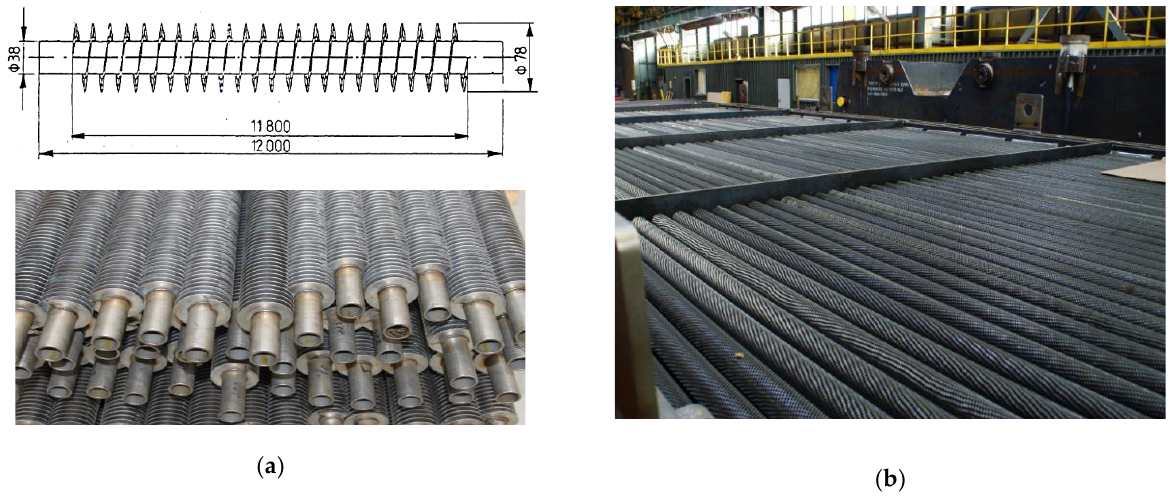
Figure 1. Finned tubes with incised fins manufactured by Energoinstal SA, Poland ( a ) and a heat exchanger made of finned tubes – evaporator, Hattorf boiler ( b ).